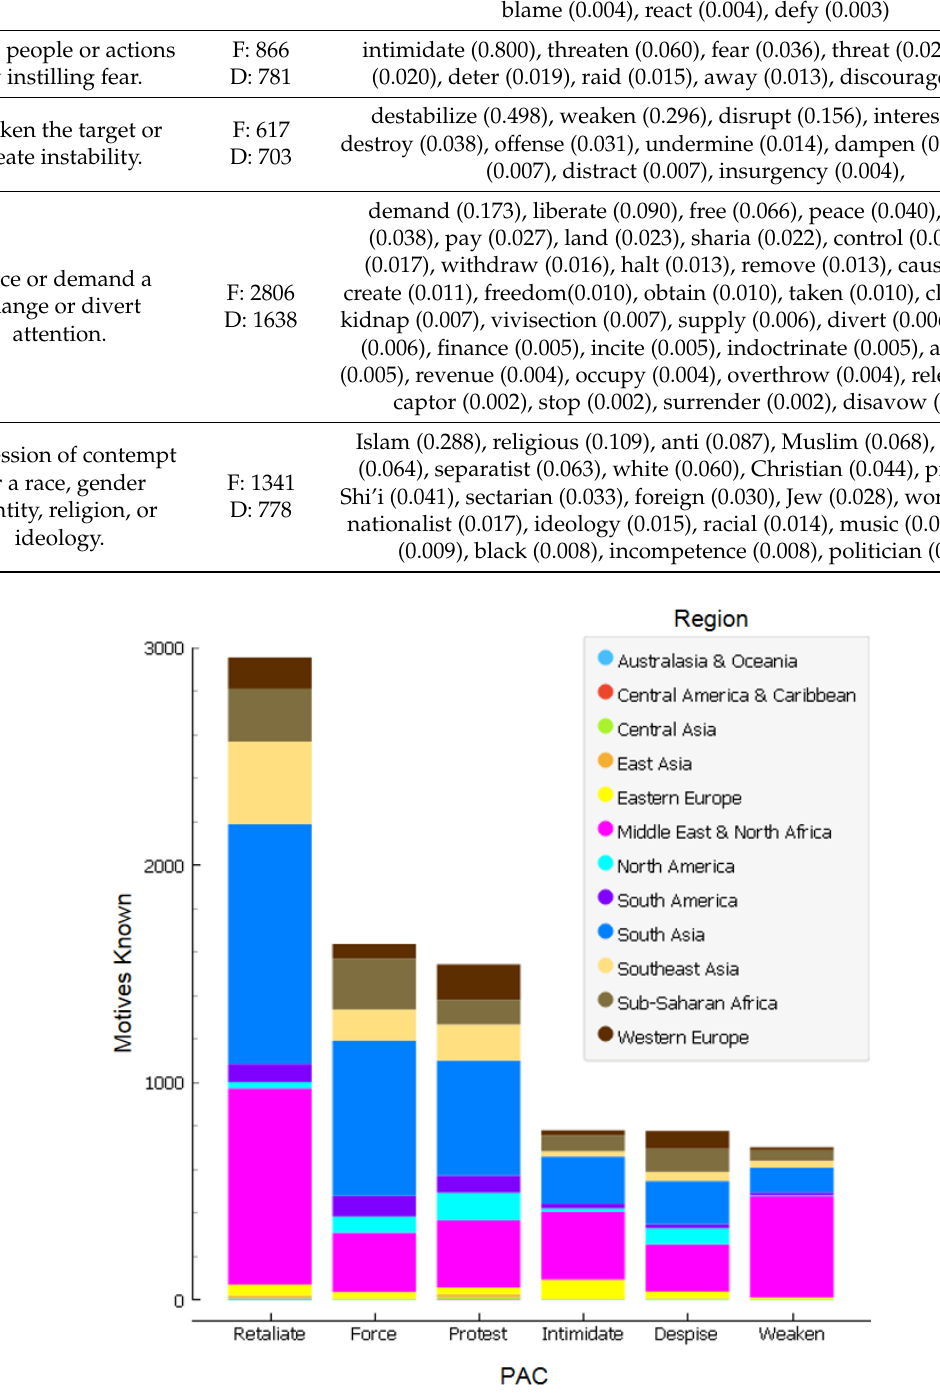
Figure 4. PAC distribution in regions of the world.